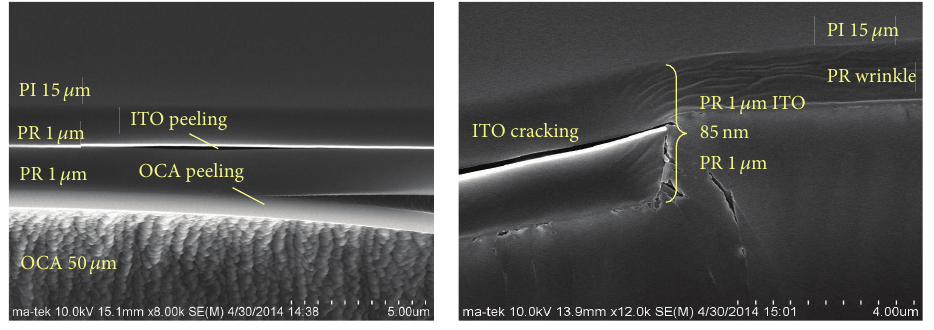
Figure 1: Failure mechanisms of a TDP structure under